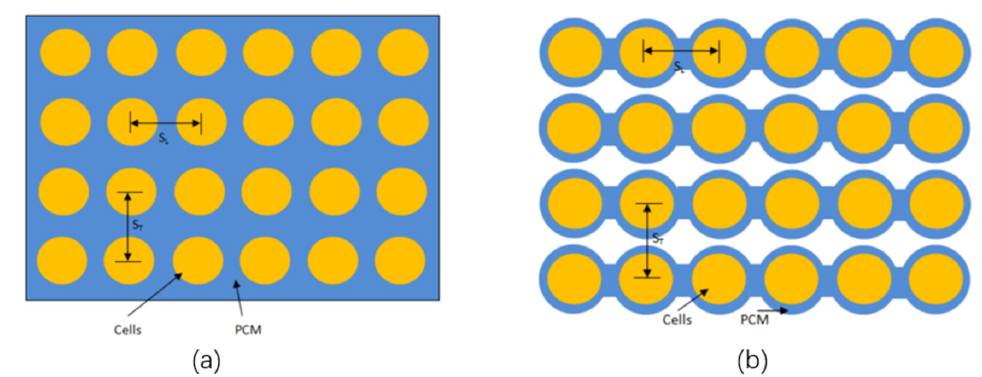
Figure 5. Structure of PCM-filled battery pack, ( a ) traditional rectangular PCM-filled battery pack, ( b ) improved PCM-filled battery pack [40]. Reproduced from reference [40] with permission from Elsevier B.V., copyright